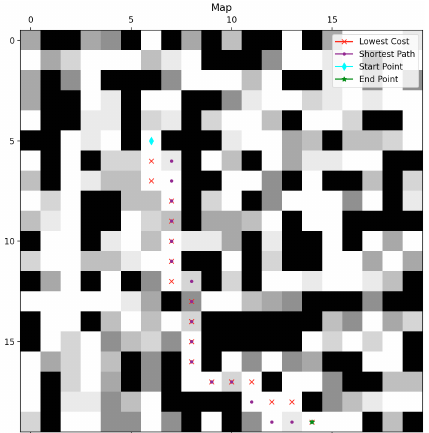
Figure 3. An example of path-planning results for map information and the ground